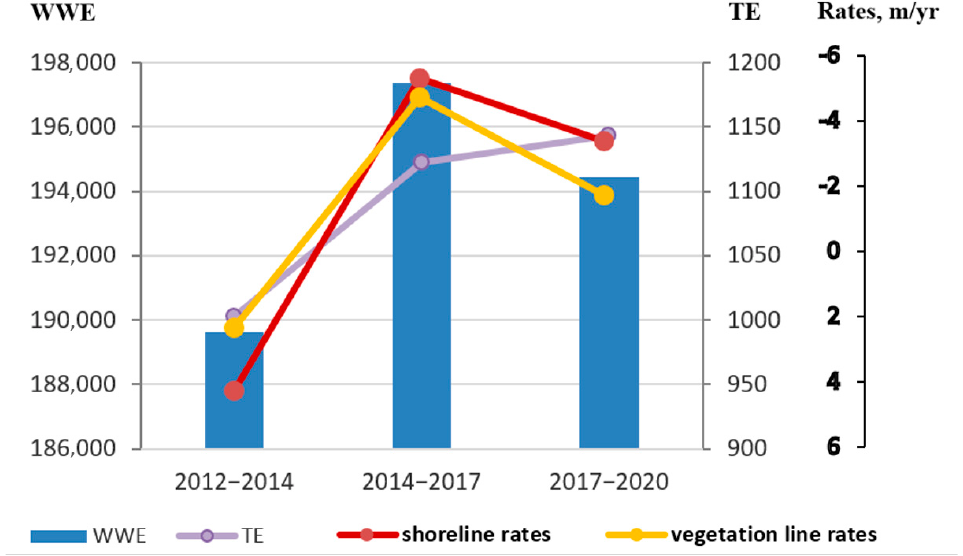
Figure 11. Hydrometeorological forcing and rates of coastal retreat/advance for the periods of study. Wind-wave energy (WWE, kg·10 3 per ice-free period). Thermal energy (TE, sum of daily average temperatures above 0 °C per year).